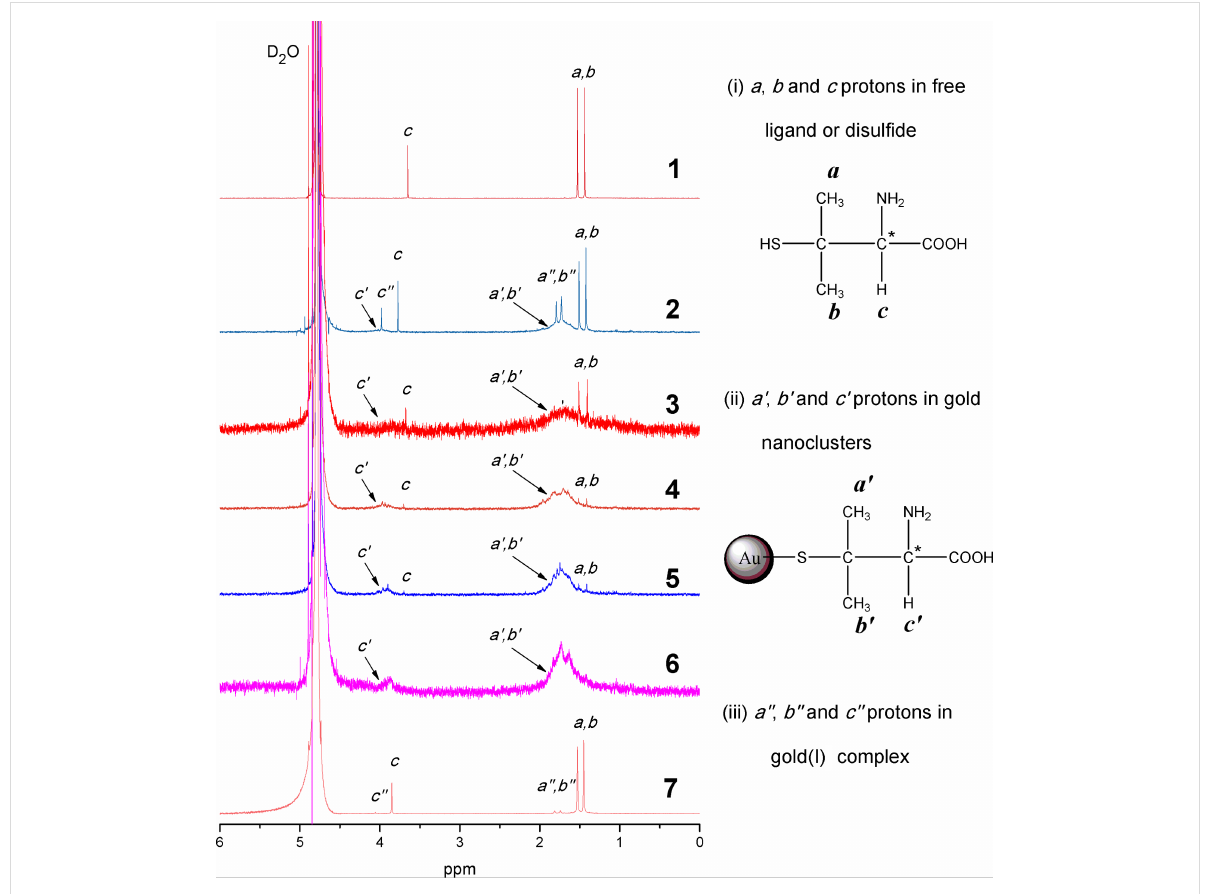
Figure 5: 1 H NMR spectra of the (1) free ligand penicillamine, (2) crude penicillamine-protected AuNC product and the sequential size-selected frac- tions (3) F 36% , (4) F 54% , (5) F 72% , (6) F 90% , and (7) F 0% .